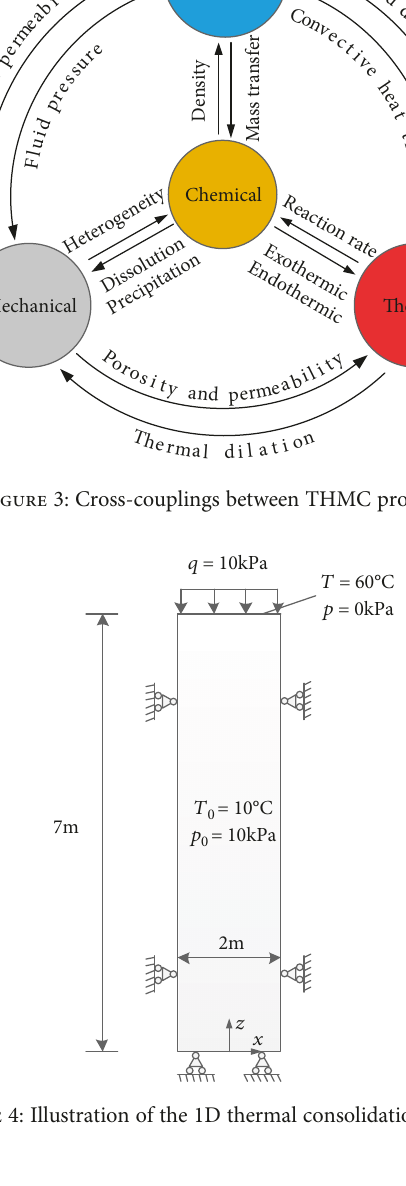
λ pf and f with temperature and pressure.